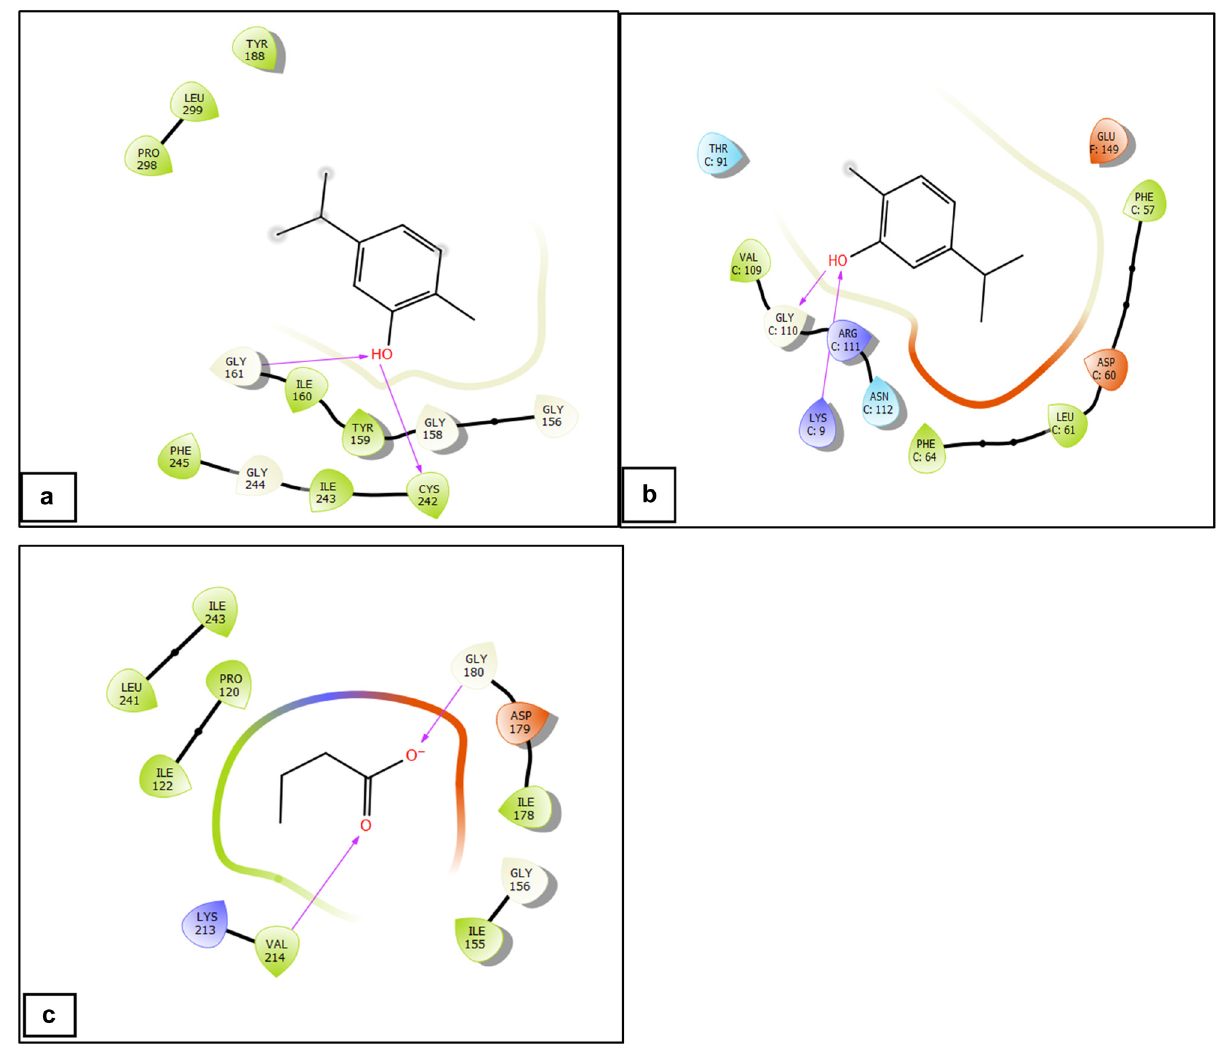
Figure 5: 2D Diagrams of ligand interactions with the active site. ( a ) and ( b ) Carvacrol interactions with the active sites of NADPH oxidase and 3Q8U; ( c ) Piperitenone interactions with the active sites of